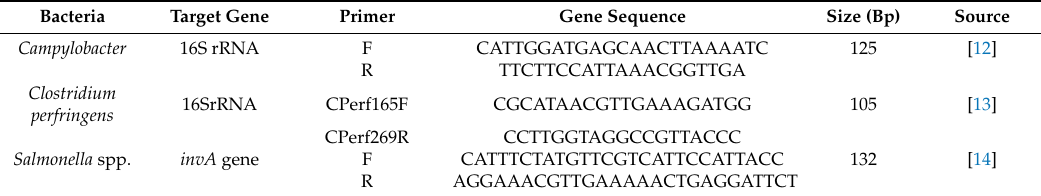
Table 3. Description of primers selected for Q-PCR reactions for the detection of Campylobacter , Clostridium, and Salmonella